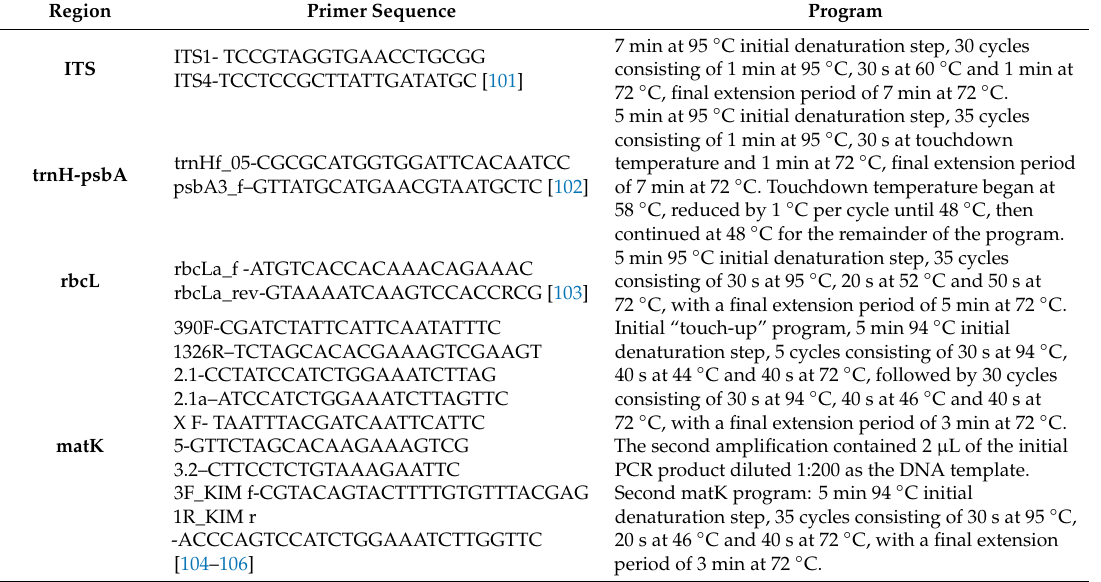
Table 7. Primers and programs used for amplification of barcode